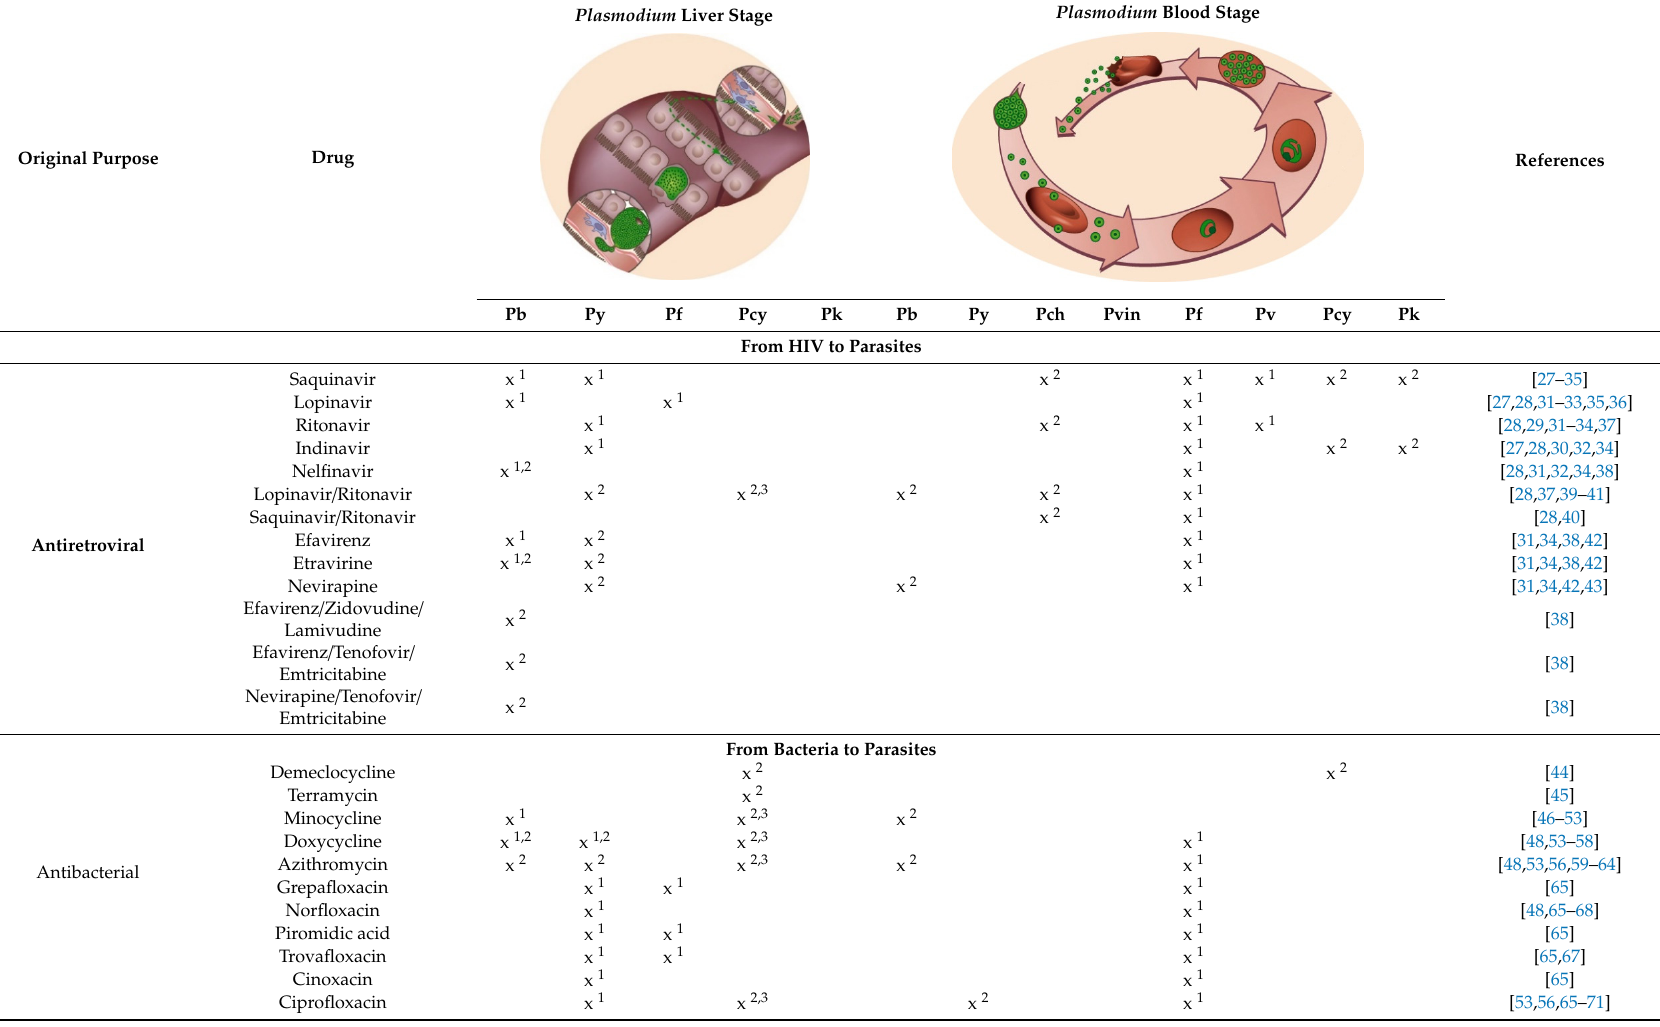
Table 1. Summary of drugs that have been tested against the liver and / or blood stages of Plasmodium infection.